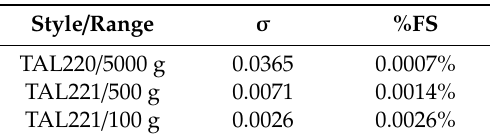
Table 4. The average standard deviation for each load cell during testing with standard masses is compared as a percentage of the load cell’s total range. These results reinforce the idea that the precision of the load cell is a function of its range and style.